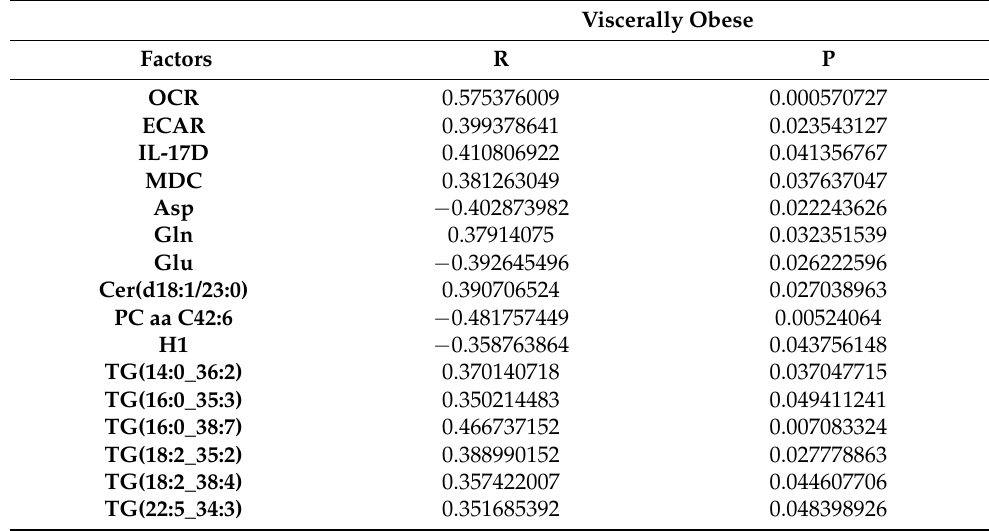
ing only significant correlations ( p < 0.05) between experimental data and visceral obesity (Spearman correlation, blue indicates positive correlations and red indicates inverse negative correlations). The Holm–Bonferroni post hoc correction was used to control for multiple comparison testing. All data expressed as mean ± SEM, obese n = 16, non-obese n = 16, * p < 0.05, ** p < 0.01, *** p < 0.001. Table 2. Significant correlations associated with visceral obesity and metabolic profiles, pro- inflammatory mediators, metabolites, and lipid analysis as illustrated in Figure 1E. Viscerally Obese Factors